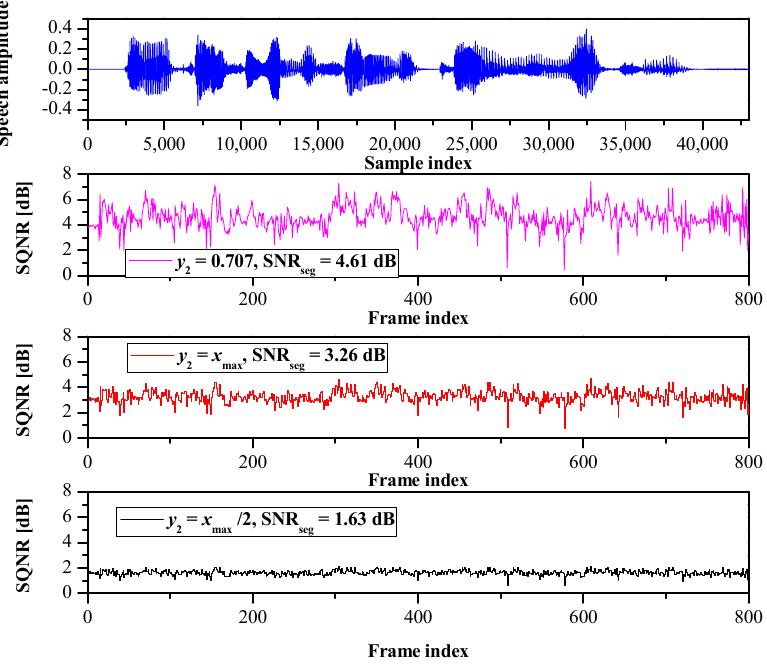
Figure 10. SQNR across speech frames in the case of PCM.